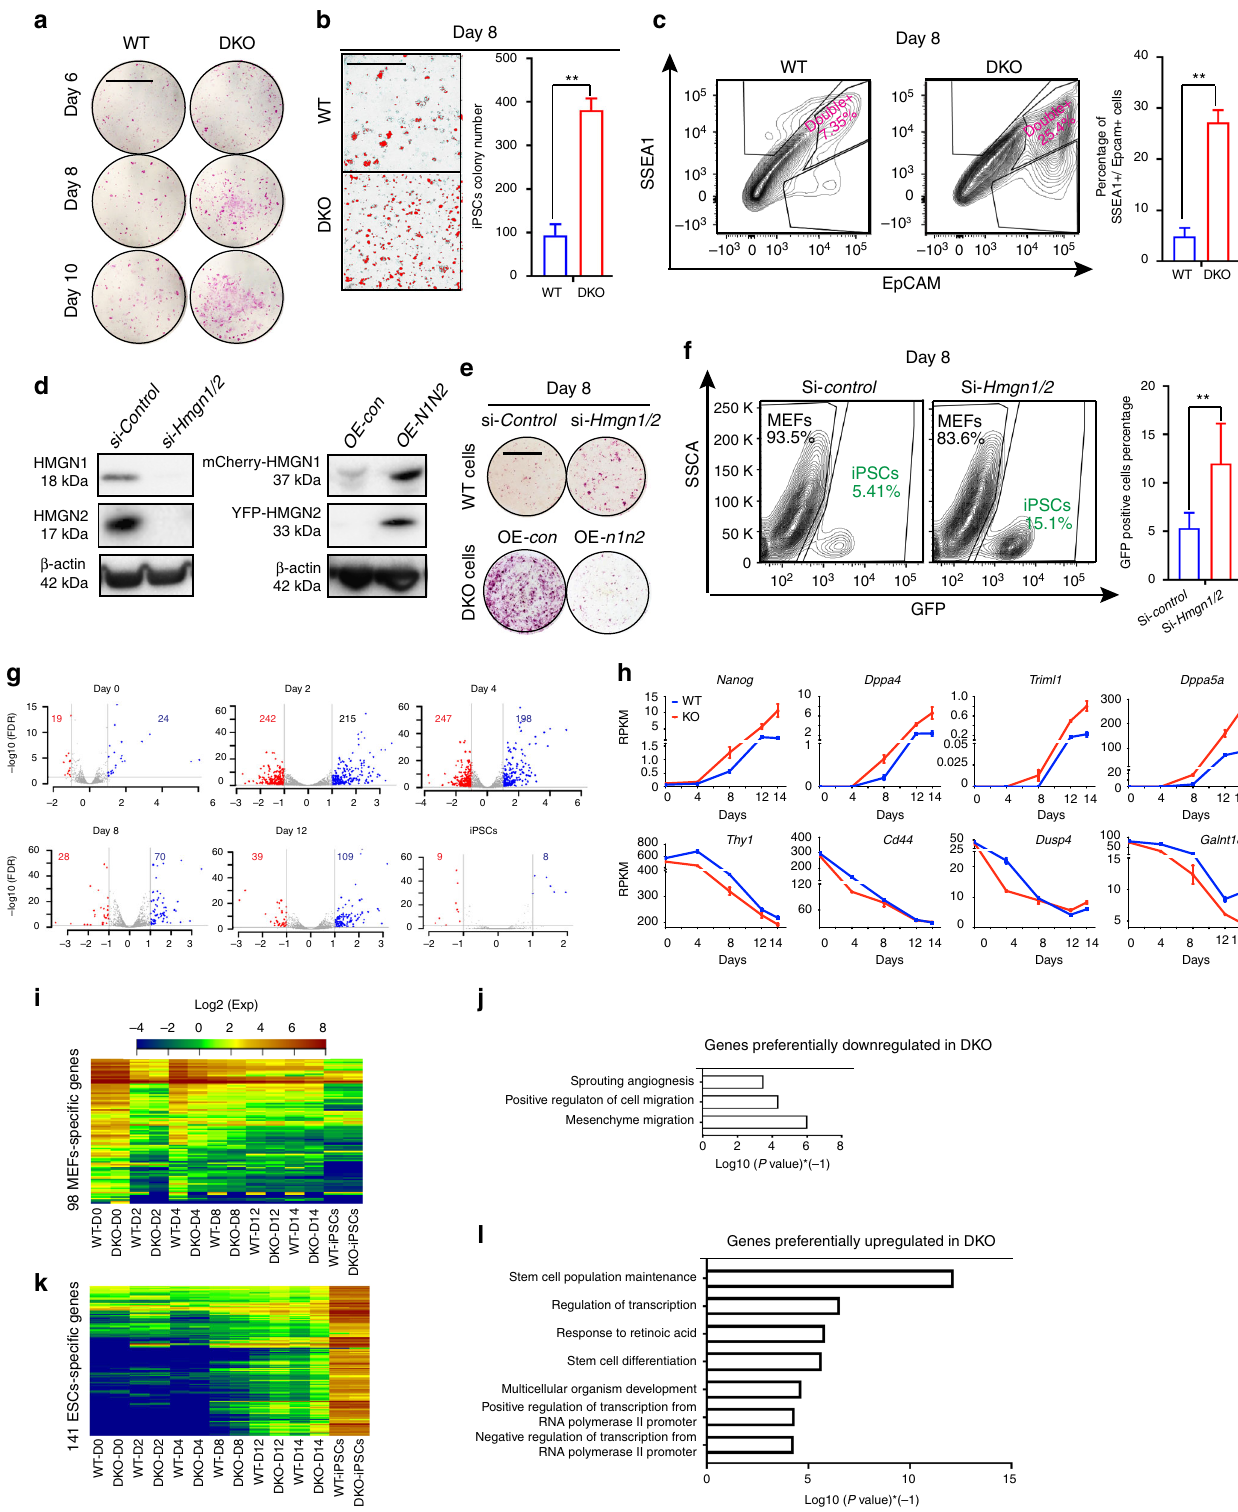
fi nding that is consistent with the relatively small changes in gene expression pro fi les (Fig. 2g). However, at reprogramming day 2, the H3K27ac signal at MEF-speci fi c enhancers in DKO cells is only half of the signal seen in WT cells, an indication of faster erasure of MEF speci fi c enhancer marks in DKO cells. In contrast, at day 8, the H3K27ac signal at ESCs-speci fi c enhancers in DKO